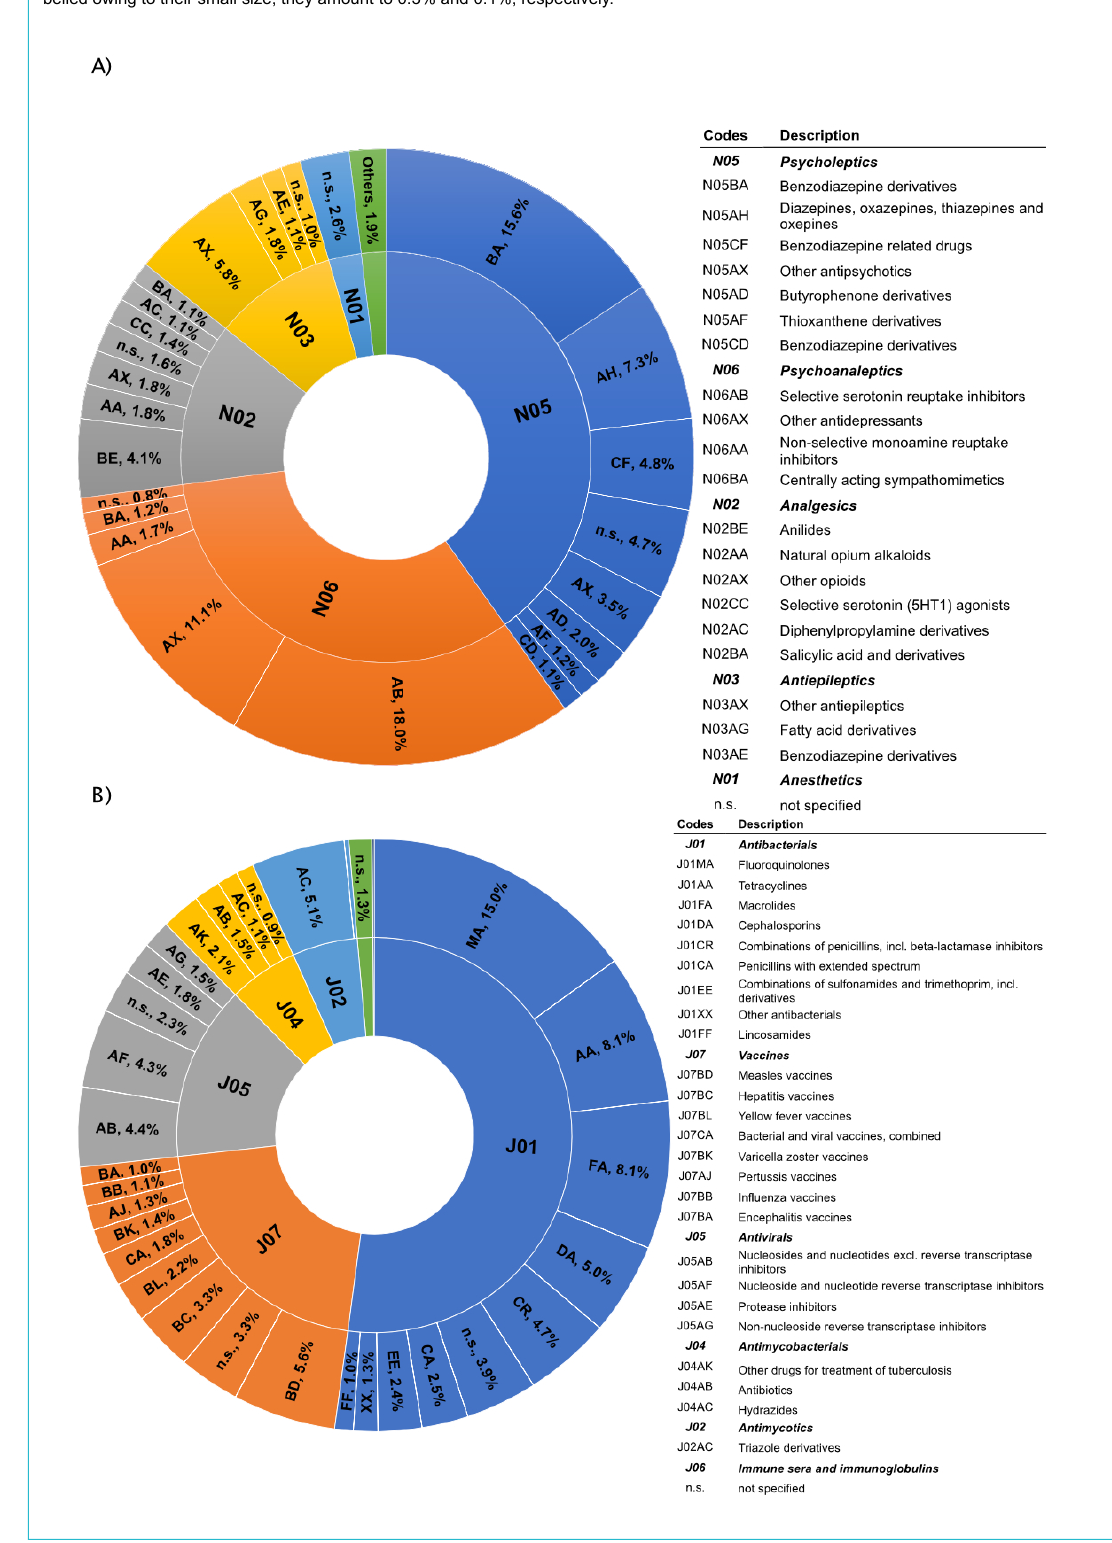
Figure 4: Medications for the nervous system (A, anatomical main group N; n = 7042) and anti-infectives for systemic use (B, anatomical main group J; n = 1586) mentioned in the queries to the STIS. The light green sector “Others” in A is not labelled owing to its small size. The same applies to the light green sector “J06” in B. The subsector “n.s.” from the therapeutic subgroup “J02” and the sector “Others” in B are not la- belled owing to their small size; they amount to 0.3% and 0.1%,